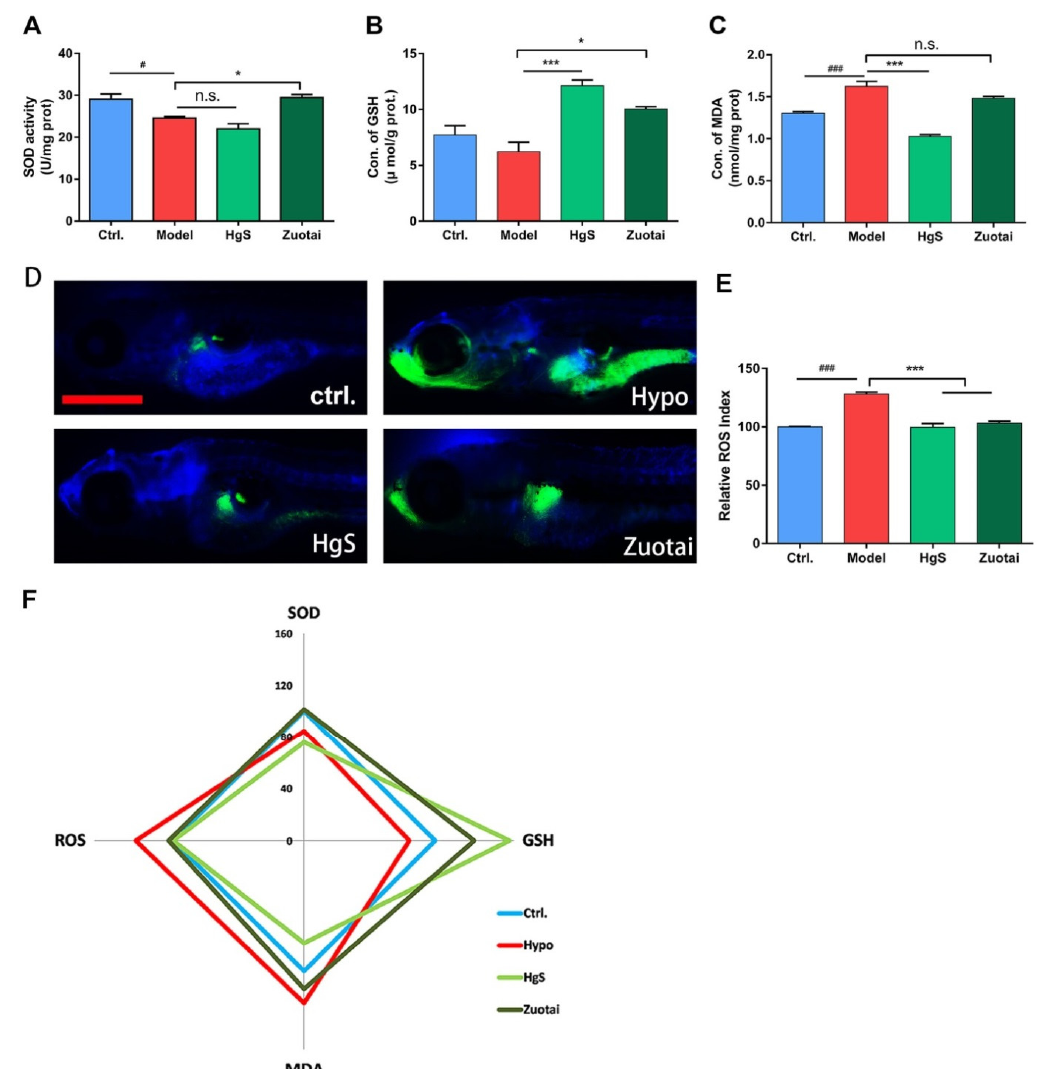
Figure 5. HgS and Zuotai regulated redox state of larval zebrafish. ( A ) SOD activity, ( B ) GSH content and ( C ) MDA content of each treated zebrafish tissues samples. ( D ) ROS production of larval zebrafish showed in the image (green fluorescence). (Scale bar: 2 mm). ( E ) Quantitation of relative ROS level of larval zebrafish. ( F ) Radar chart of 4 indexes showing the effects of HgS and Zuotai in vivo study. # P < 0.05, ### P < 0.001 represent compared with control, * P < 0.05, *** P < 0.001 represent compared with the model (hypoxia group), n.s., no significant differences.